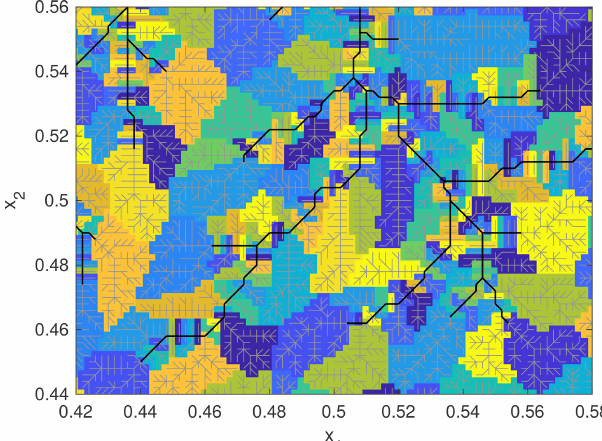
Figure 4. Flow pattern of the central region of Fig. 1. Black lines show rivers with A ≥ A c for A c = 100 pixels. Gray lines are chan- nels with A < A c , considered to be hillslope sites. Each colored area consists of one channel site plus the hillslope area that drains into this site without passing another upstream channel